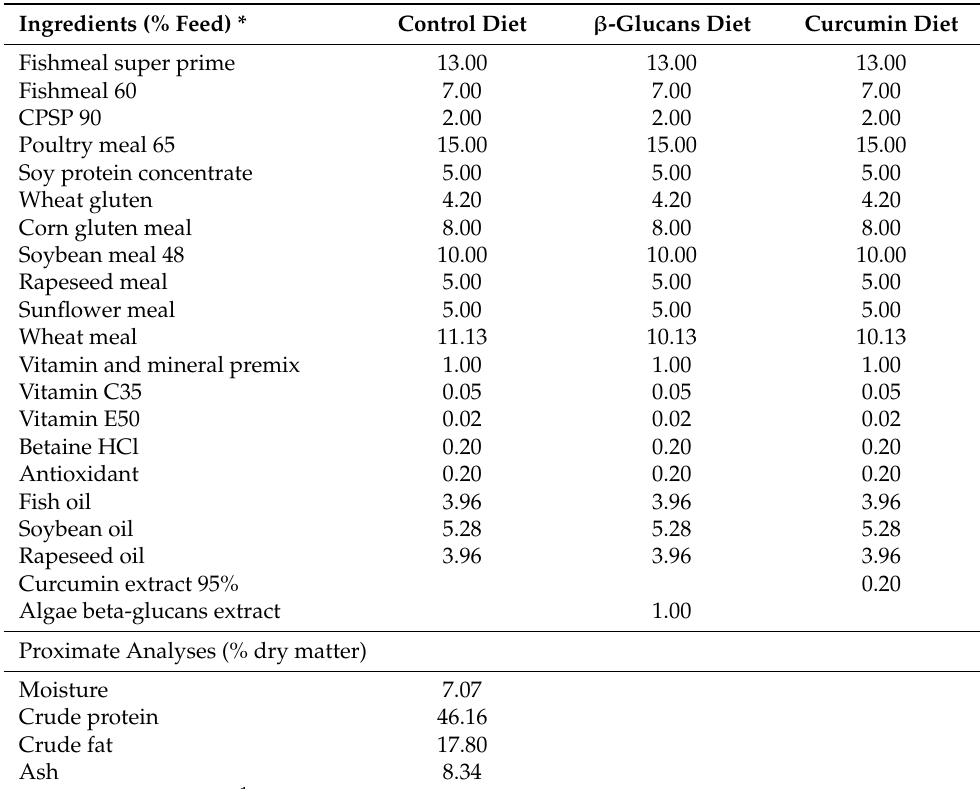
Table 1. Ingredient and chemical composition of the diets (feeding